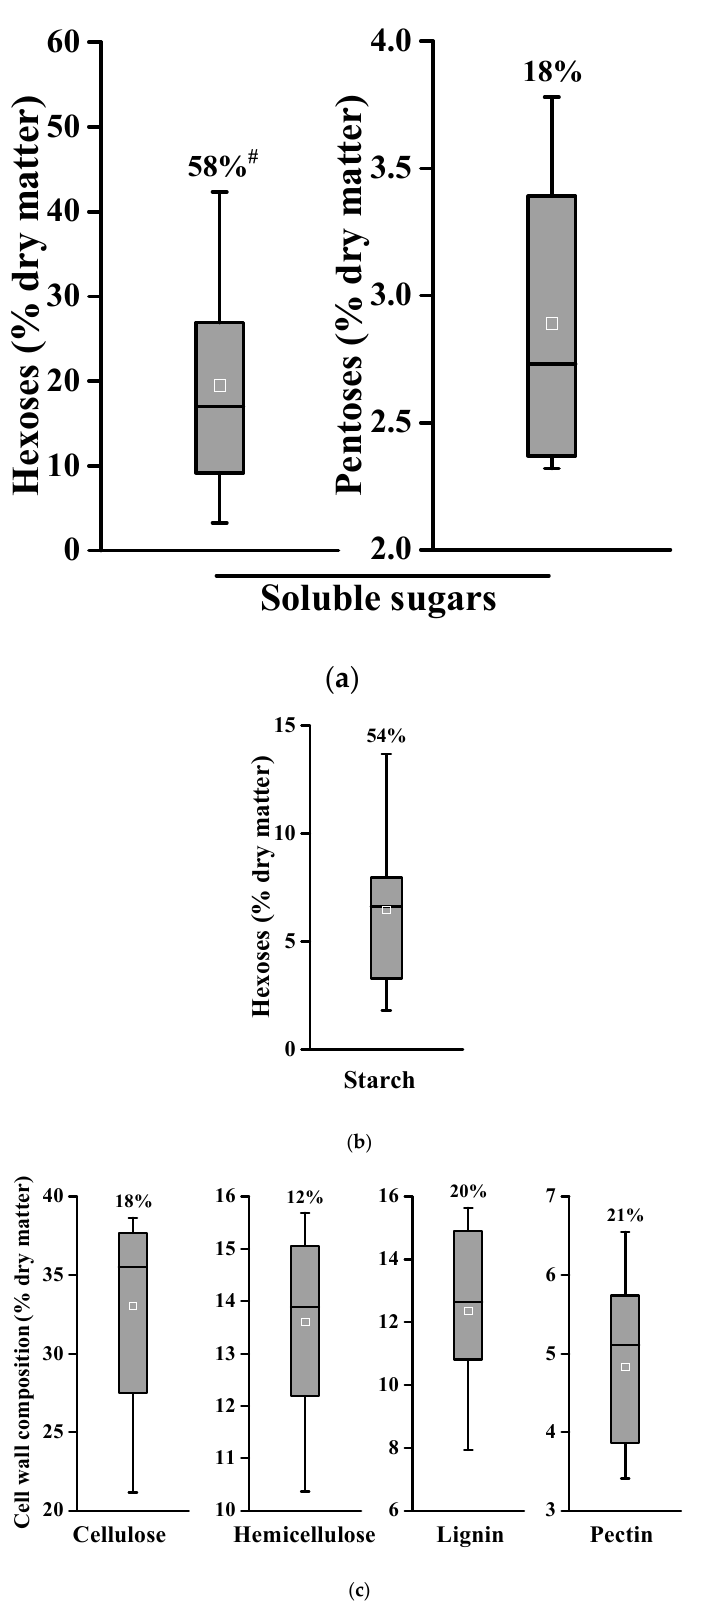
Figure 1. Variation of edible carbohydrates and lignocellulose compositions among 11 total banana samples. ( a ) Soluble sugars, ( b ) Starch, ( c ) Wall polymer composition. # As coefficient of varia-